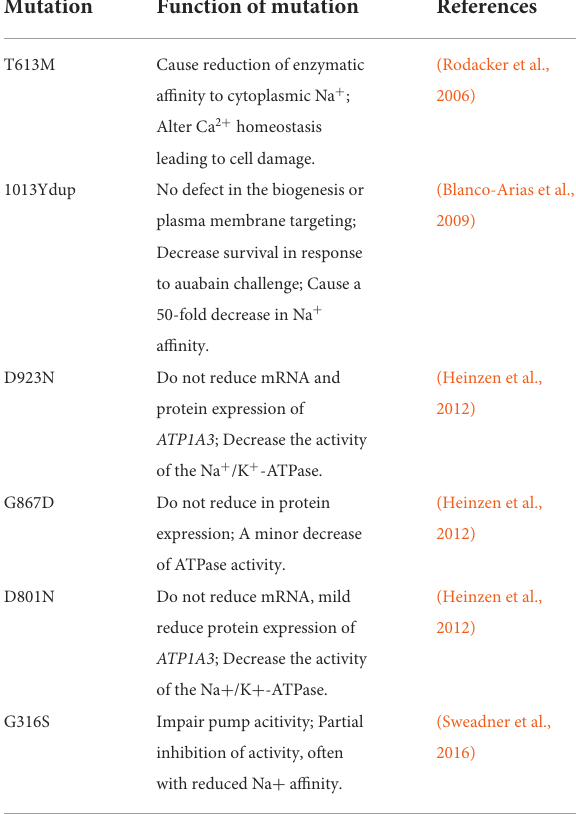
TABLE 4 The functional findings of ATP1A3 mutations on RDP and intermediate